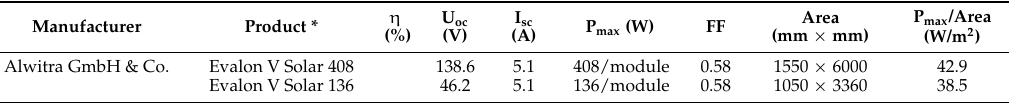
Table 1. Literature data for one of the building integrated photovoltaics (BIPV) foil products [3].